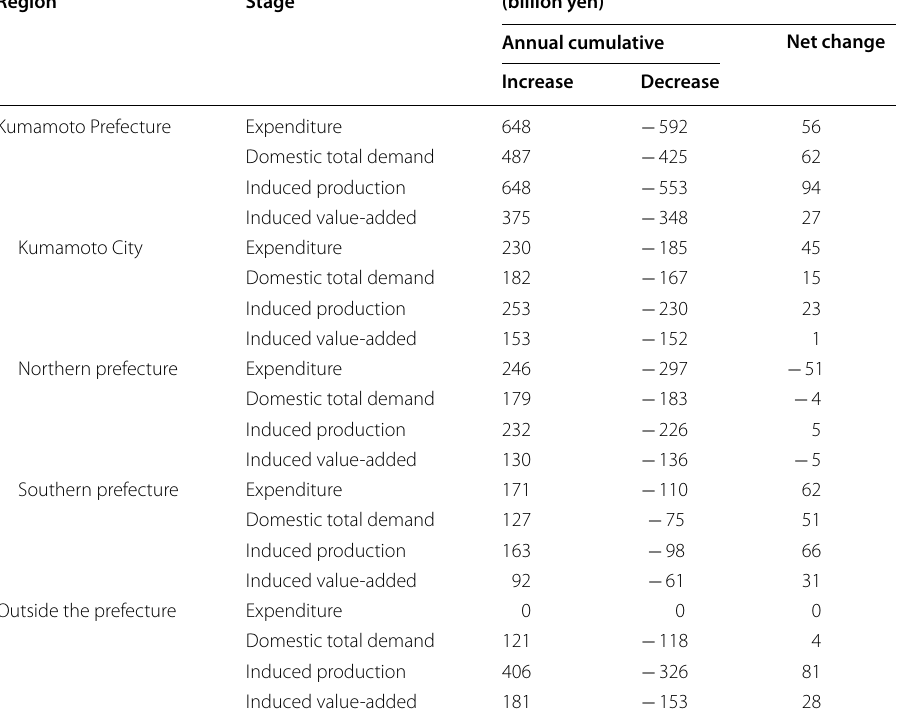
Table 2 Annual cumulative increase and decrease in expenditure and ripple